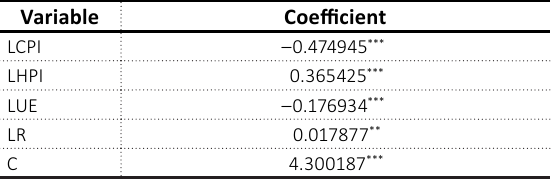
Table 2. A long-run model